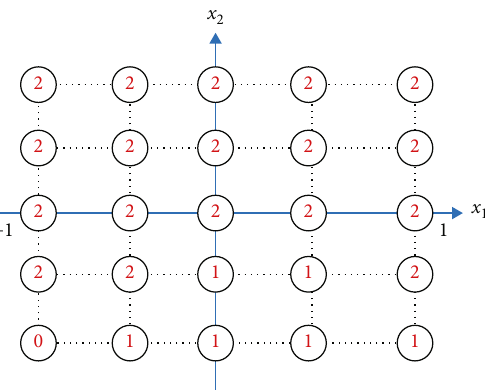
Figure 8: Second generation of f